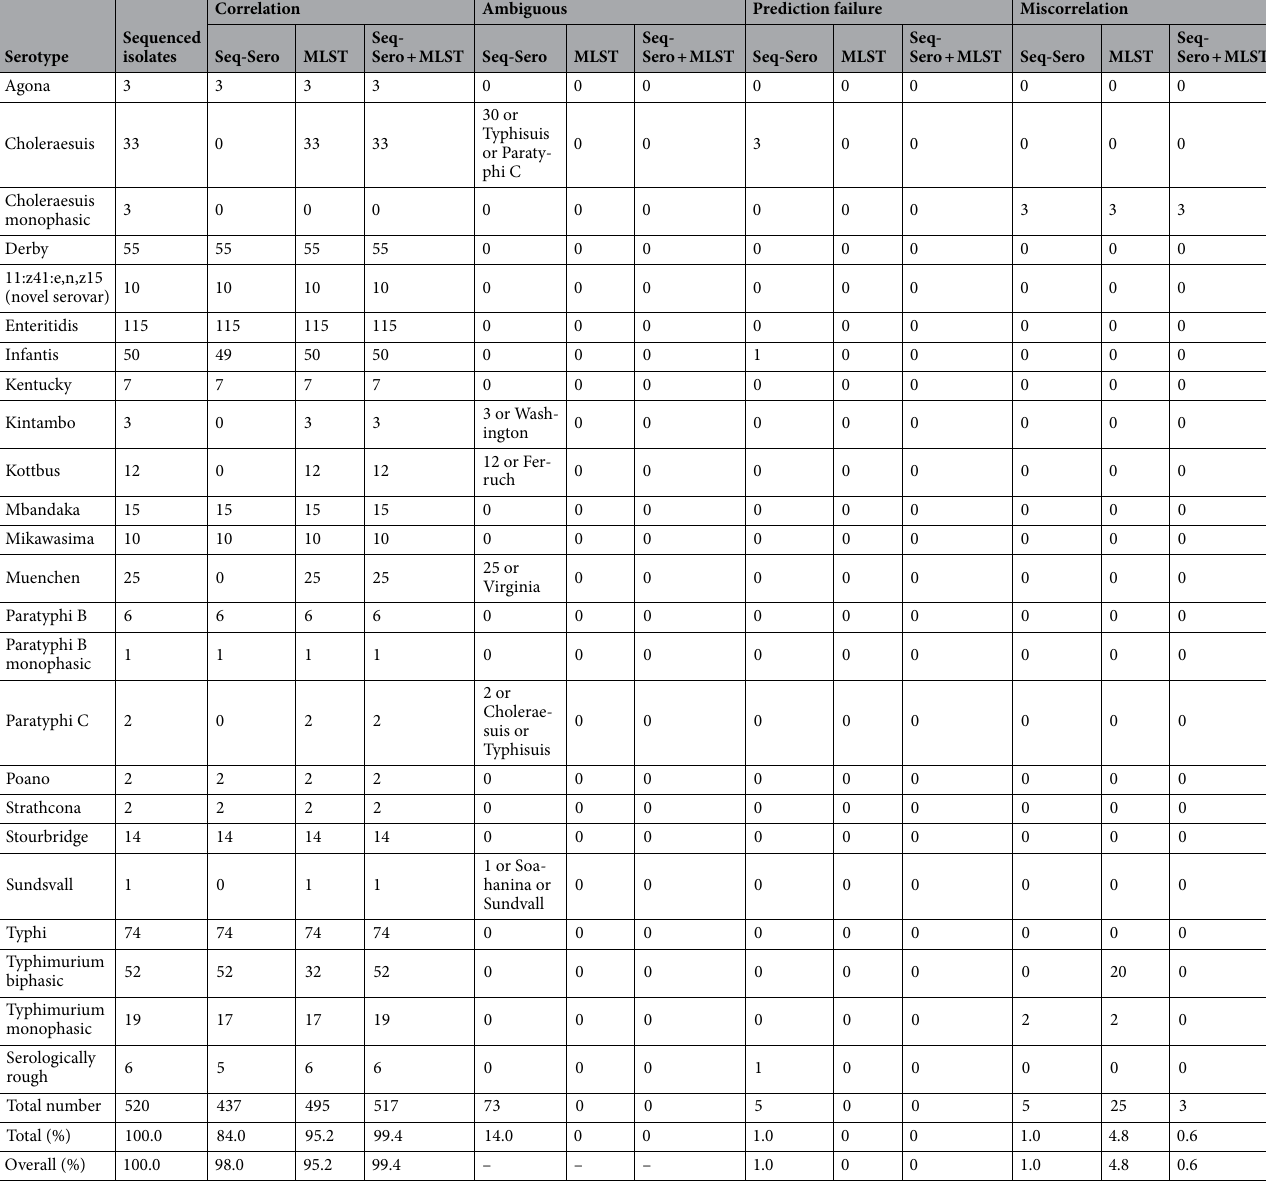
Table 1. Overview of serotype prediction with SeqSero and MLST. Serotype was first determined by classical serotyping. Whole genome sequences were then analyzed with SeqSero or MLST. Correlation means that the predicted serotype was the same as the classically determined serovar. Ambiguous means that the correct serotype was listed among others. Prediction failure means that no complete antigenic formula was derived. Miscorrelation means that a wrong antigenic formula was derived. Overall (%) is the sum of Ambiguous (%) and Correlation (%). Final results are shown, i.e. after resequencing if data quality was not